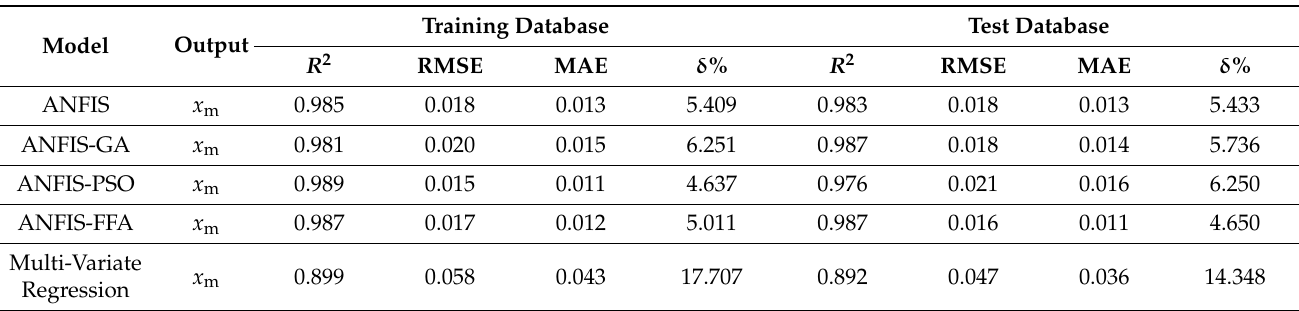
Table 4. Models’ performance evaluation for output x m